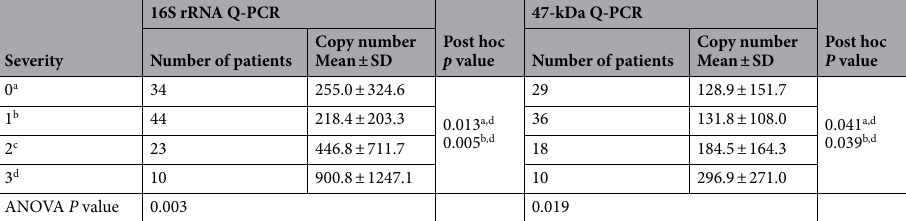
Table 1. Mean copy number detected by 16S rRNA Q-PCR and 47-kDa Q-PCR according to the severity grade divided into four levels. SD standard deviation.